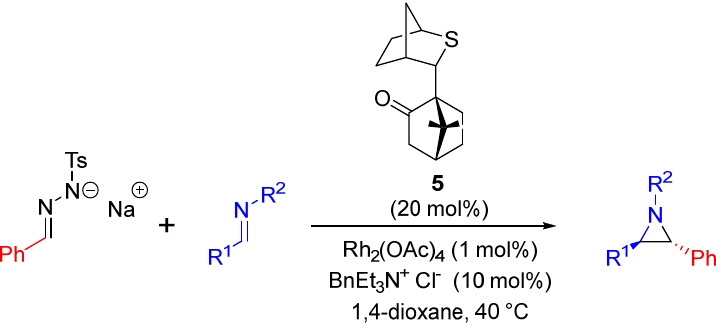
Table 11. Scope of Aggarwal’s catalytic enantioselective synthesis of aziridines (Scheme 34). Entry